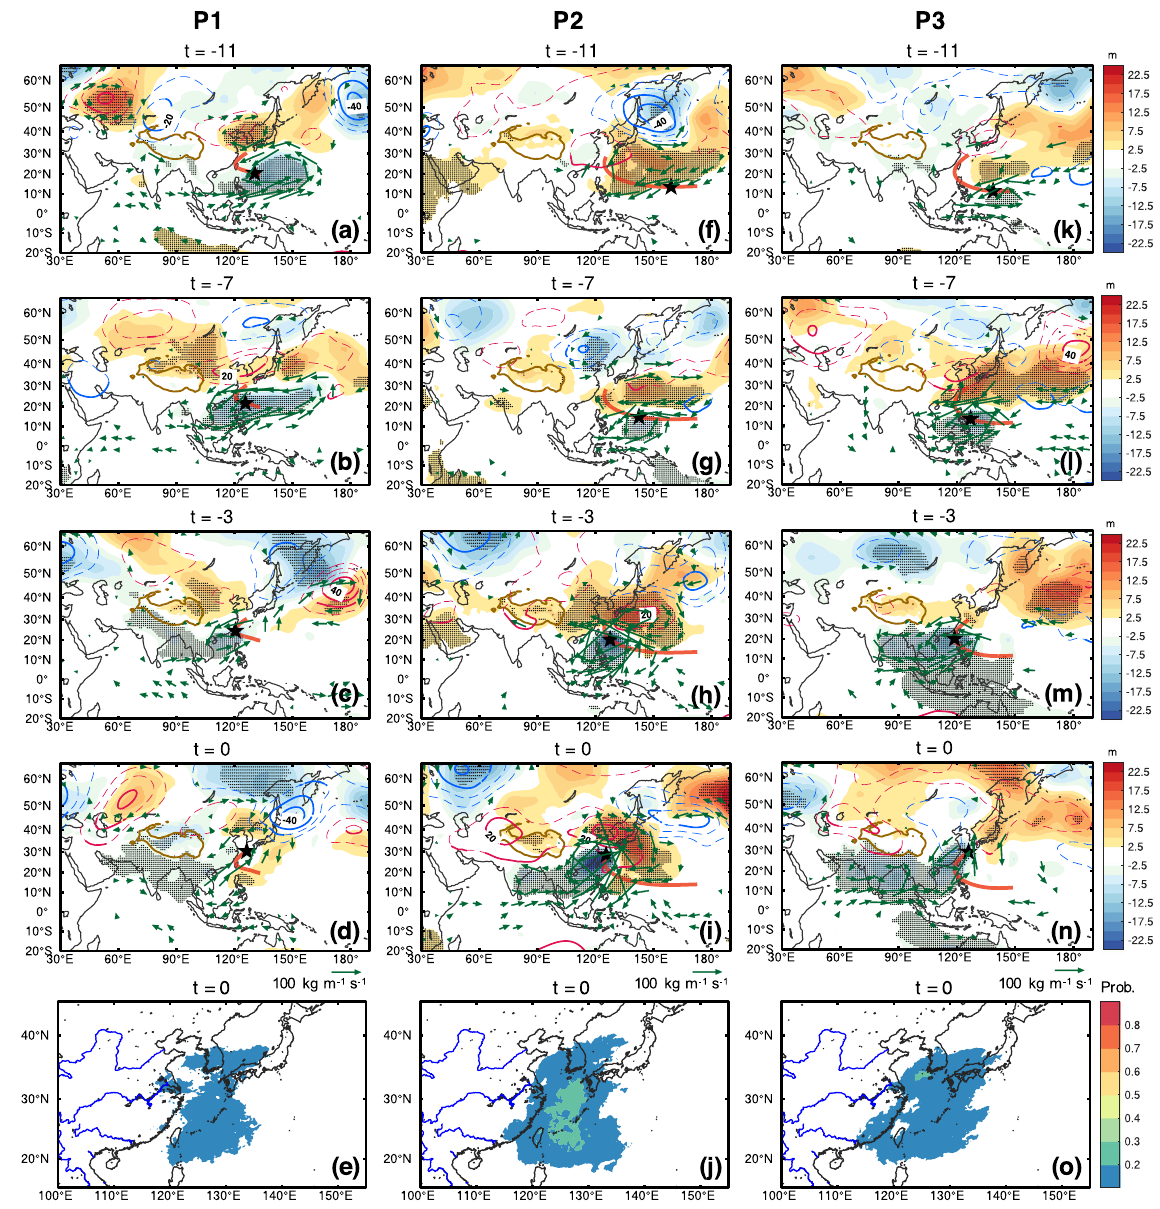
Fig. 4 Composites of meteorological fi elds within 2 weeks ahead of the clustered events fed by the P1 – 3 channels. a – e As in Fig. 2, but for P1 (121 events), f – j P2 (106 events) and k – o P3 (93 events) on day − 11, − 7, − 3, and